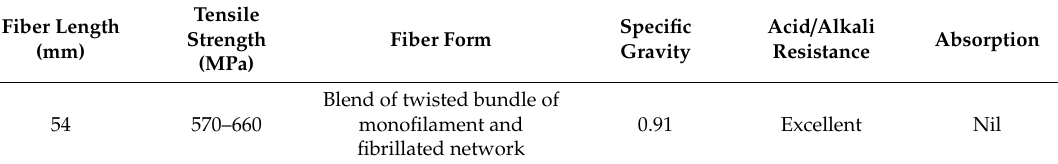
Figure 1. Twisted-bundle macro-synthetic fibers. Table 1. Fiber properties as per manufacturer’s specification.